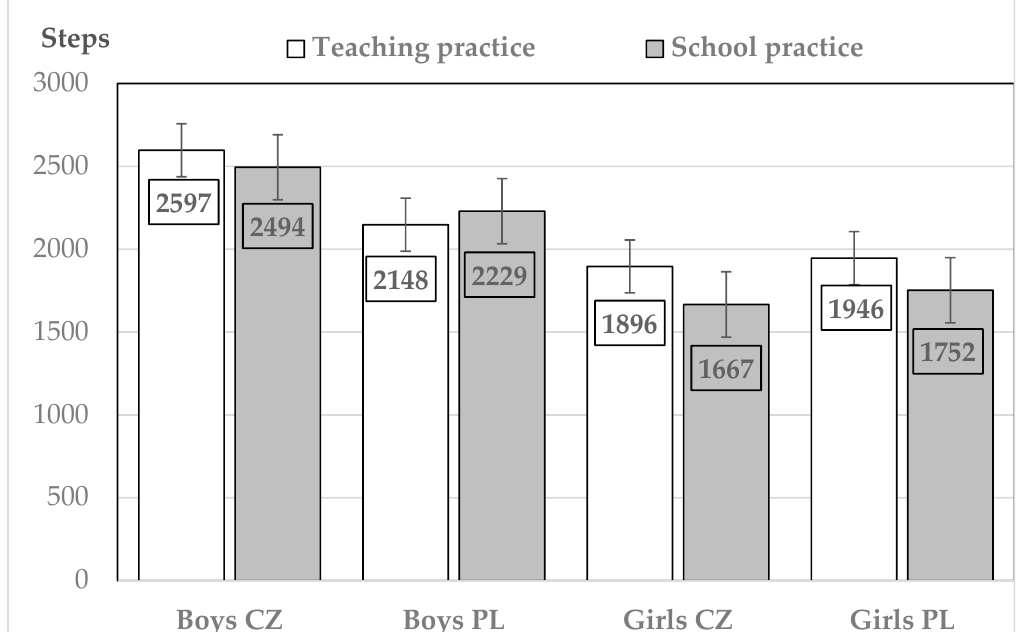
Figure 1. Comparison of step counts per PE lesson (45 min) among Czech (CZ) and Polish (PL) boys and girls during students’ teaching practice and during weekly monitoring of physical activity.